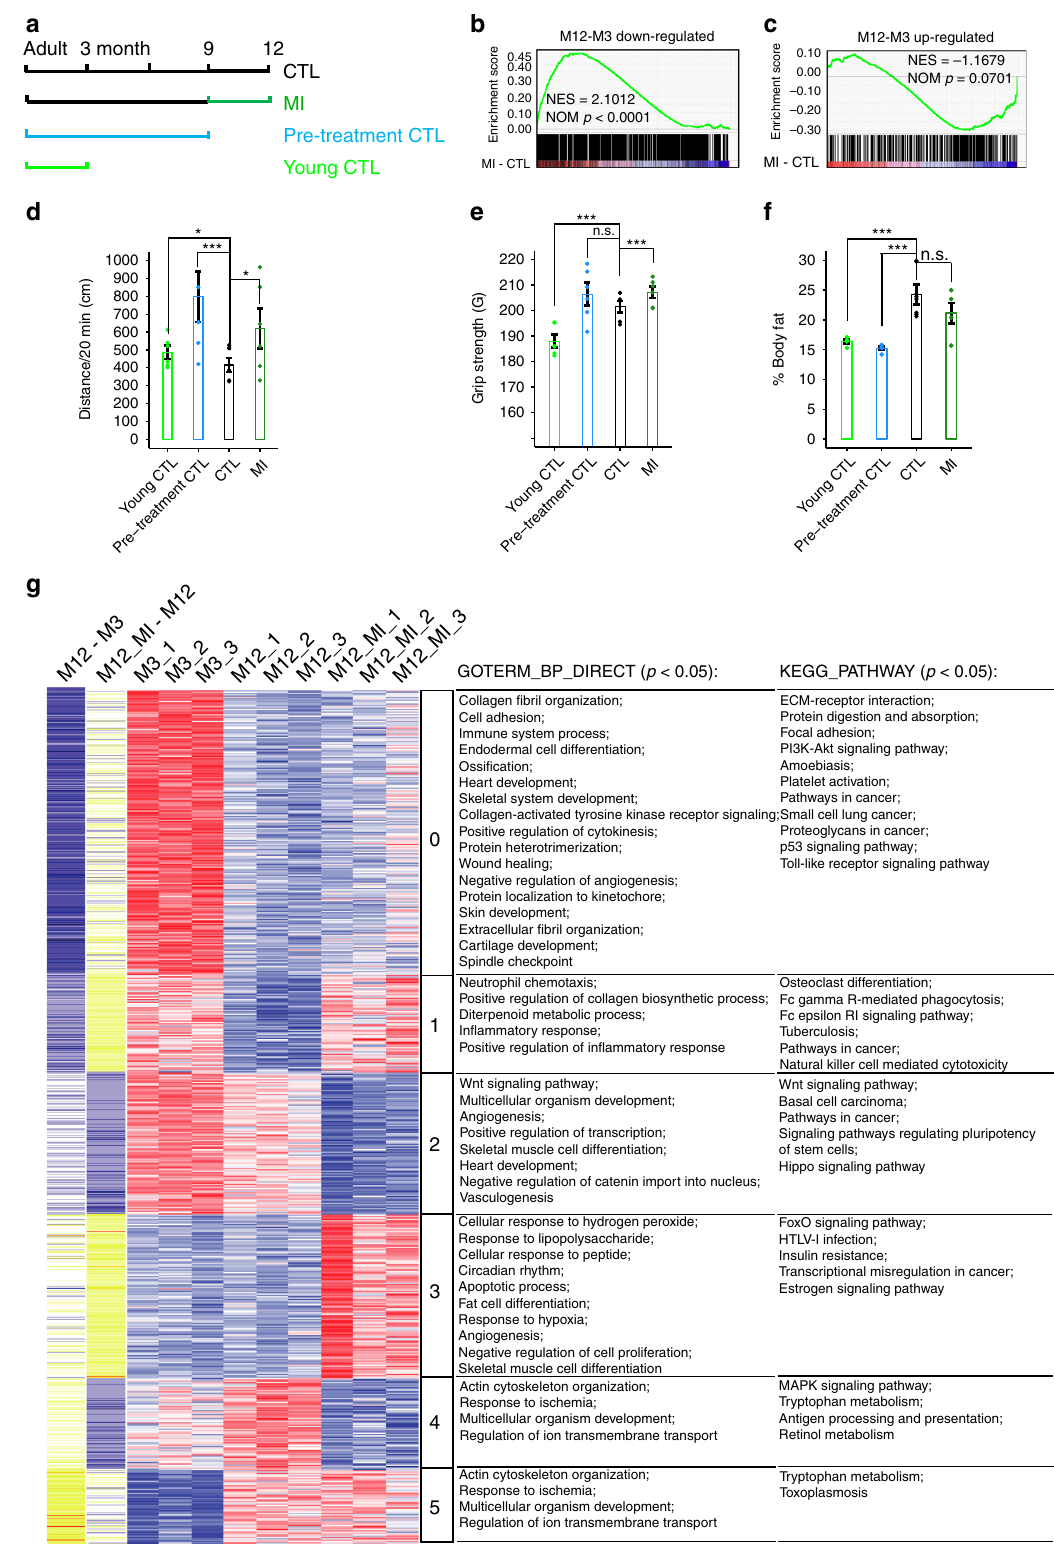
daf-18 null -allele (NL) completely blocks the aging-alleviating effect of MI . To identify the downstream target of MI or PI(4,5) P 2 , we tested many genes in classical lifespan-regulatory signaling pathways for epistasis analysis, including age-1, daf-16 , rsks-1 , ife- 2 , sir-2.1 , glp-1 , isp-1 , aak-2 , jnk-1 , nhr-49 , and found that,